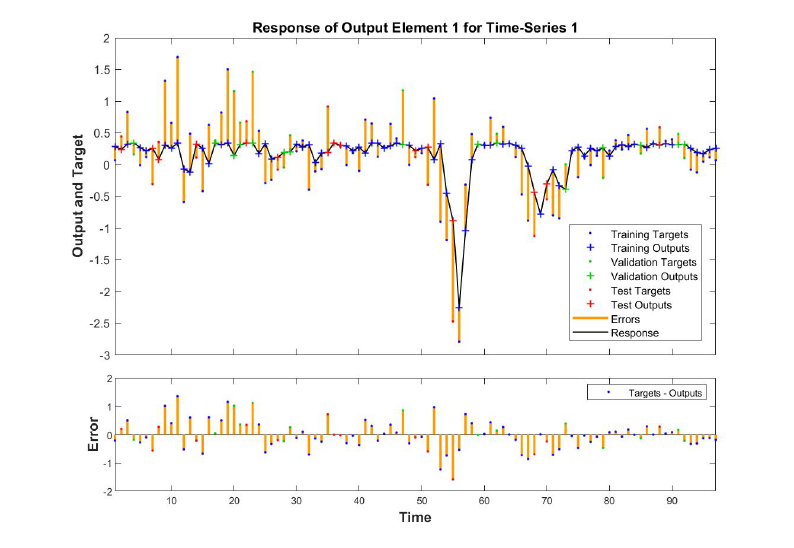
Figure 9. Italian GDP growth rate for the period from 1995:Q1 to 2019:Q2 forecast with NARX techniques (top box) and the estimation errors (Data source for GDP growth rate: OECD.Stat, 2019, ‘own elaboration’).